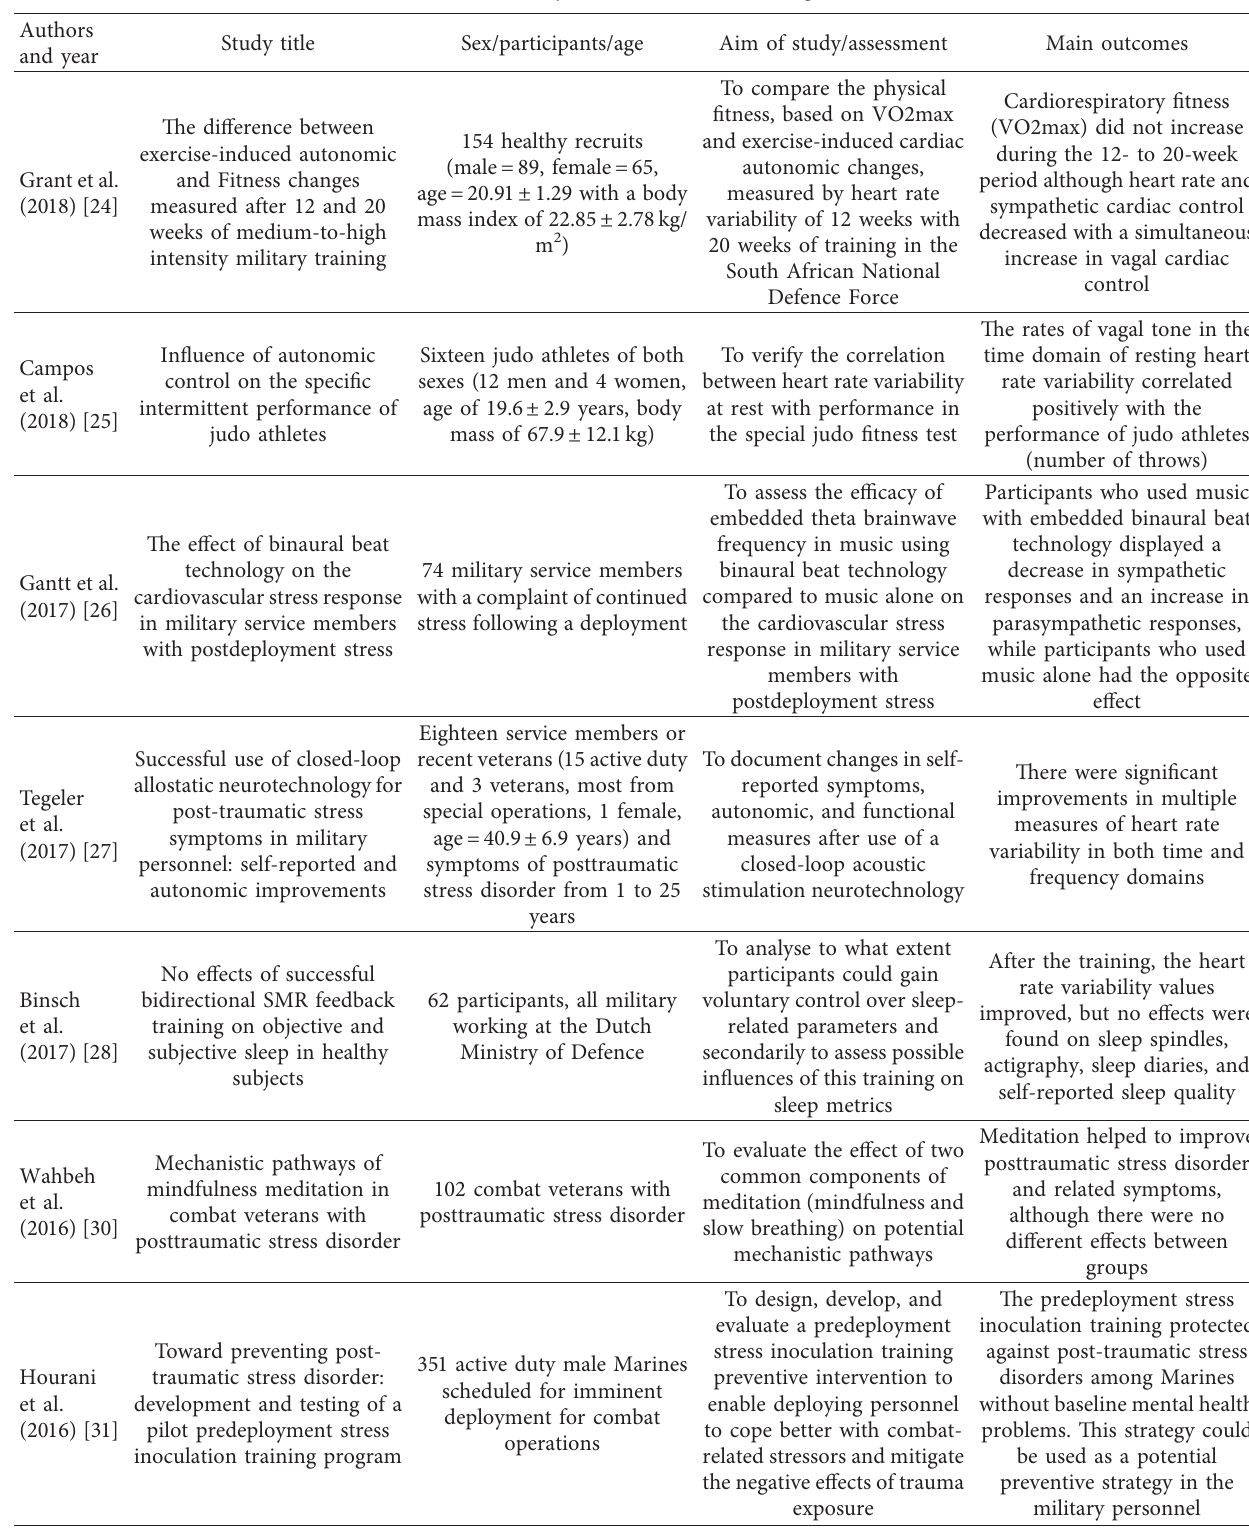
Table 2: Summary of articles about stress